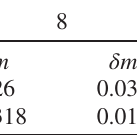
TABLE VI. Comparison of magnetization data from DMET and AFQMC at n ¼ 1 . U